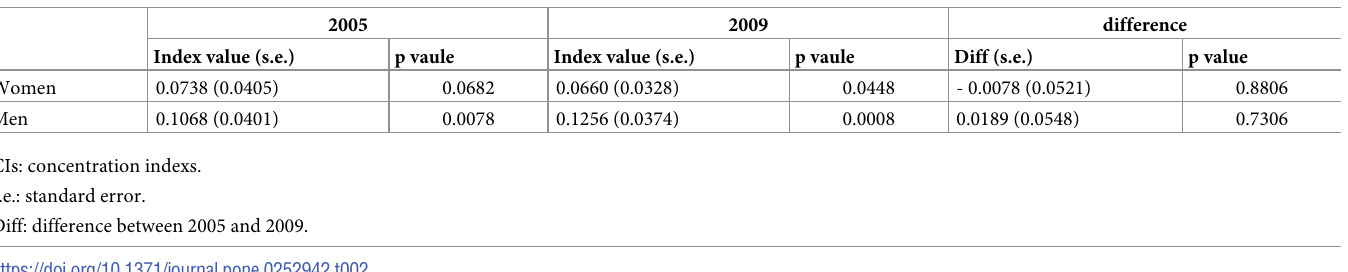
Table 2. CIs of unequal health check-ups use for 2005 and